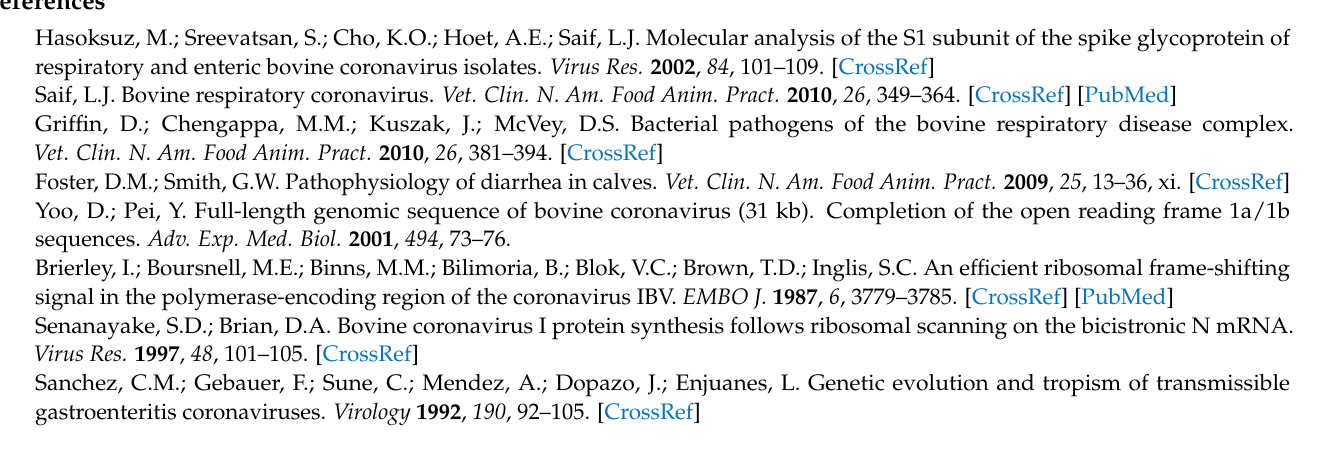
Table S2: BCoV genomes used for phylogenetic analysis. Table S3: Sequence IDs for 492 Unique Betacoronavirus HE gene sequences from NCBI. Table S4: Sequence IDs for 256 Unique BCoV HE gene sequences from NCBI. Table S5: Recombination detection in 492 unique Betacoronavirus HE gene sequences. Table S6: Recombination detection in 256 unique HE sequences with ‘bovine coronavirus’ in the